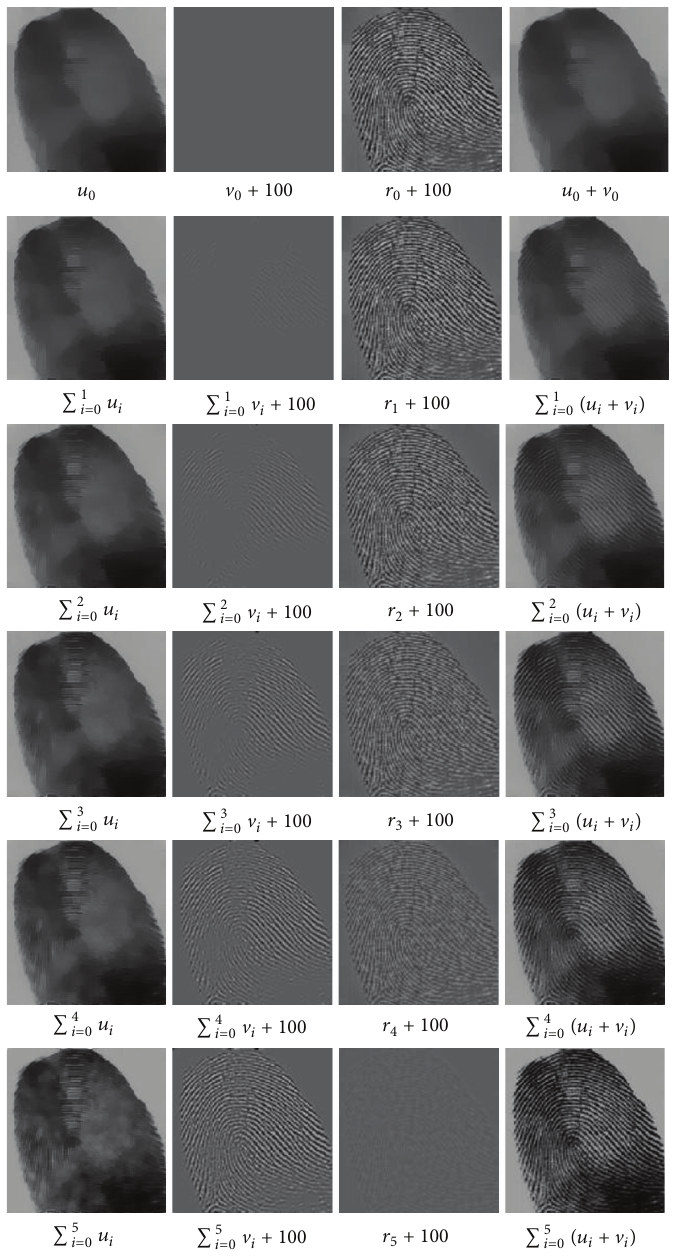
Figure 5: Multiscale texture extraction and image representation using hierarchical decomposition of a fingerprint for 6